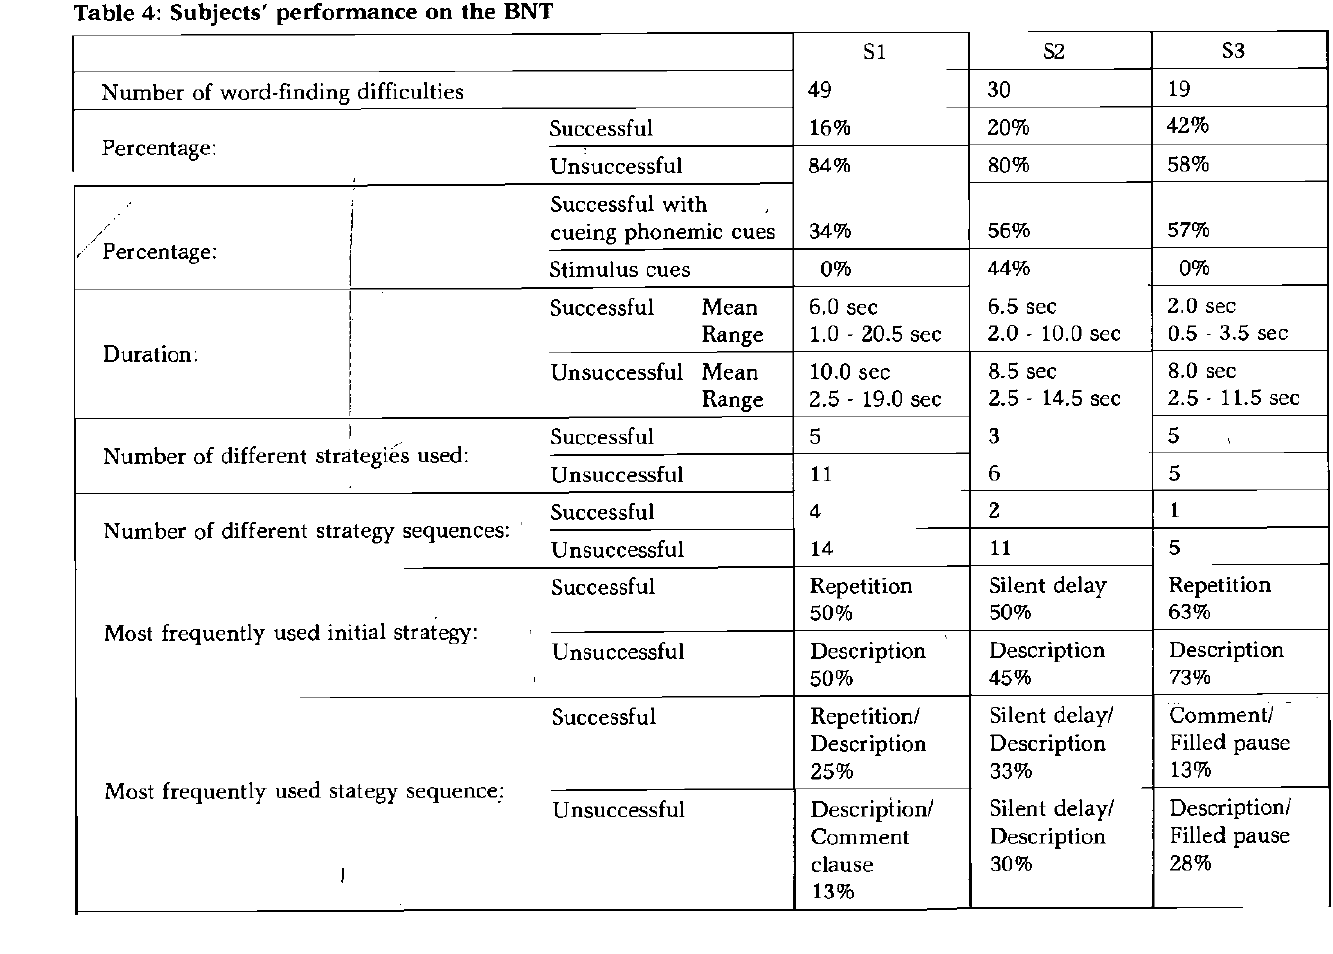
Table 4: Subjects' performance on the